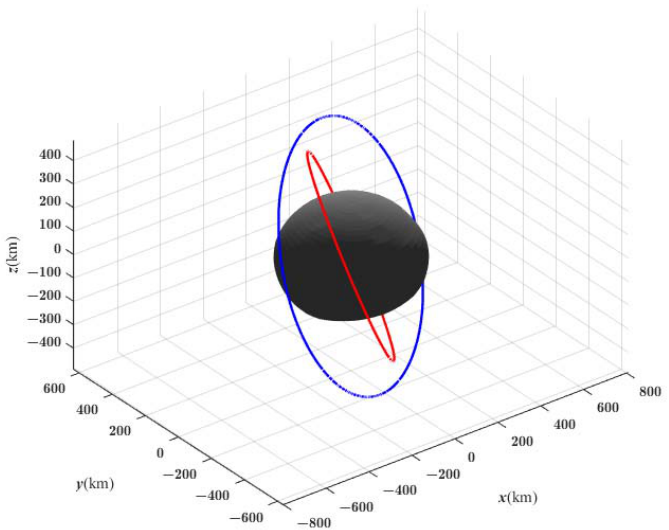
Figure 9. The repeating ground-track orbit around Vesta, with blue curve corresponding to a = 525 km, i = 68.61 deg, e = 0.0001, Ω = 30 deg, ω = 45 deg, and the repetition parameter Figure 9. The repeating ground ‐ track orbit around Vesta, with blue curve corresponding to a = 525 Z = 1.1; red curve corresponding to a = 420 km, i = 68.608 deg, e = 0.0001, Ω = 60 deg, ω = 30 deg, km, i = 68.61 deg, e = 0.0001, 30   deg, 45   deg, and the repetition parameter Z = 1.1; red and the repetition parameter Z = Figure 9. The repeating ground ‐ track orbit around Vesta, with blue curve corresponding to a = 525 curve corresponding to a = 420 km, i = 68.608 deg, e = 0.0001, 60   deg, 30   deg, and the rep ‐ km, i = 68.61 deg, e = 0.0001, 30   deg, 45   deg, and the repetition parameter Z = 1.1; red etition parameter Z = 1.6. curve corresponding to a = 420 km, i = 68.608 deg, e = 0.0001, 60   deg, 30   deg, and the rep ‐ etition parameter Z = 1.6.